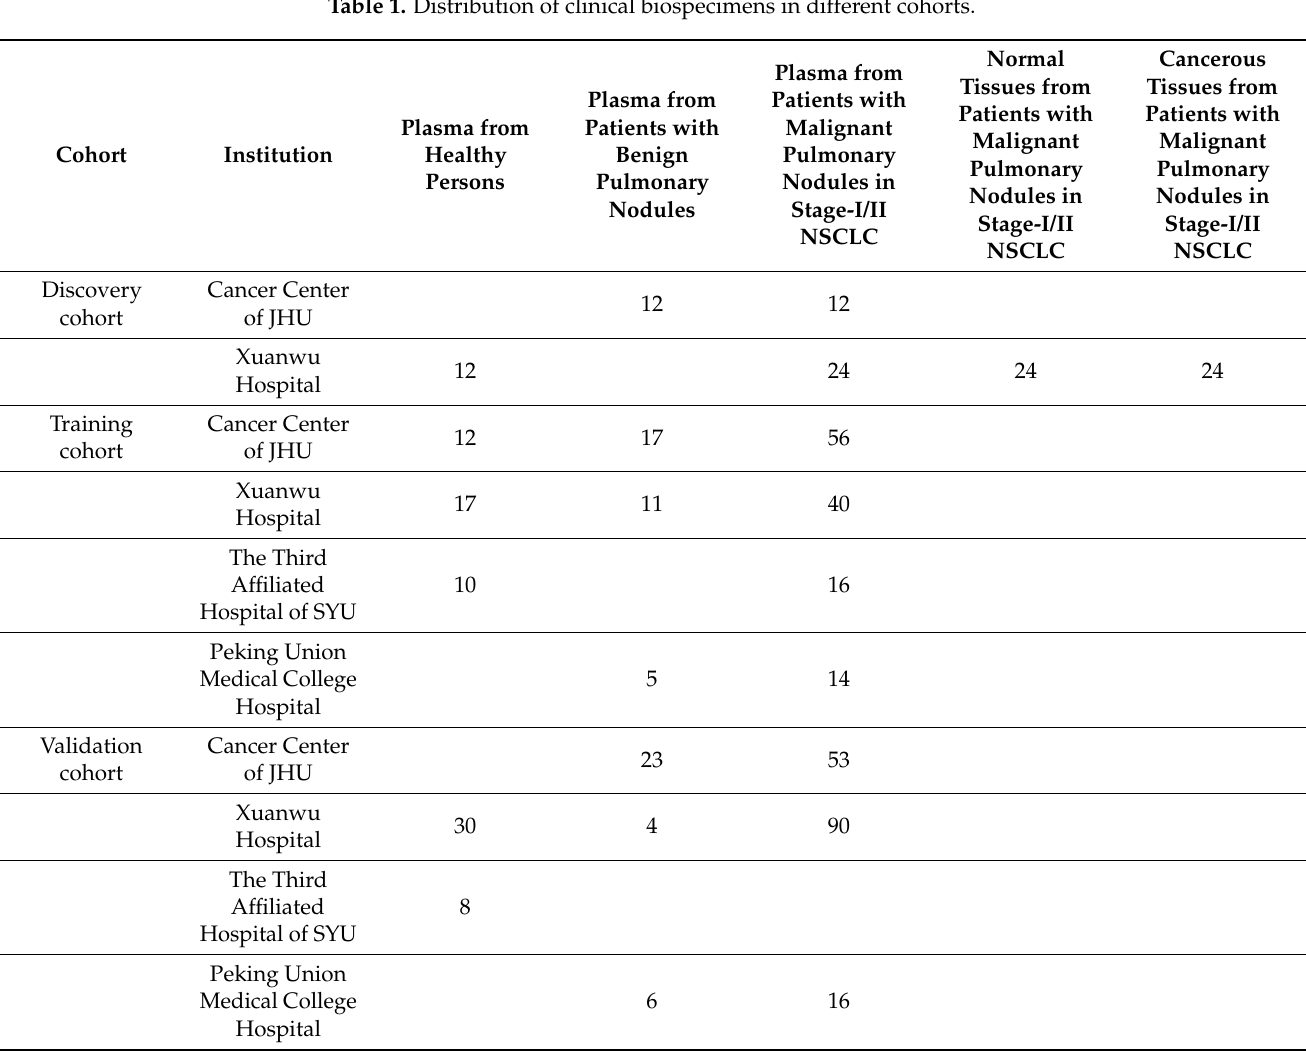
Table 1. Distribution of clinical biospecimens in different